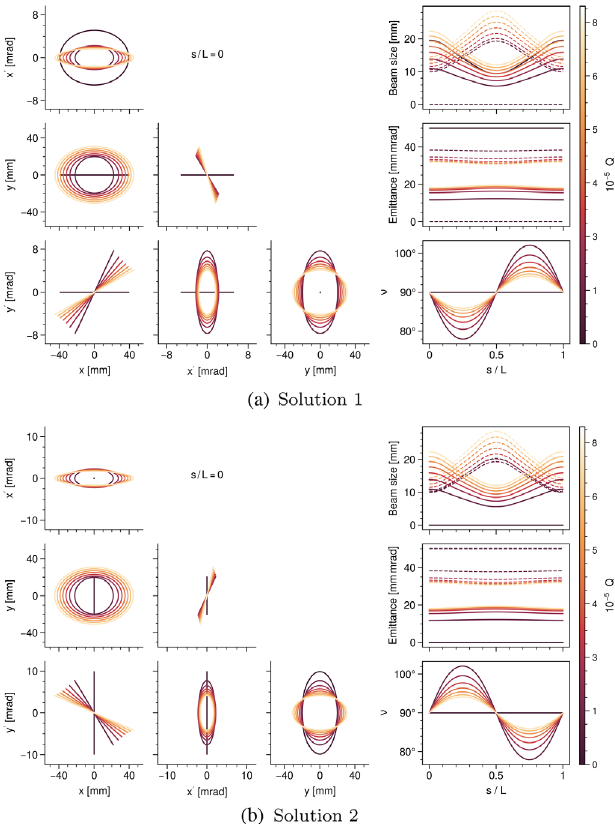
FIG. 9. Matched solution in an uncoupled FODO lattice with unequal tunes as space charge is increased with (a) ε 2 ¼ 0 and (b) ε 1 ¼ 0 . Left: phase space projections at the lattice entrance. Right: beam parameters within the lattice. Solid lines are for x and dashed lines are for y in the top two plots.